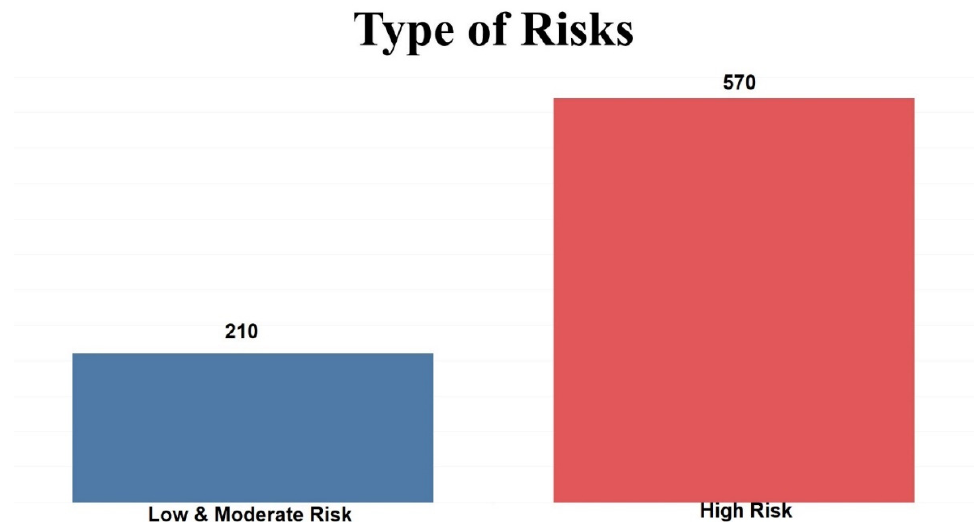
Figure 2. Number of patients in two levels of Low and Moderate Risk, and High Risk. Table 1. Demographic characteristics (N = 780).